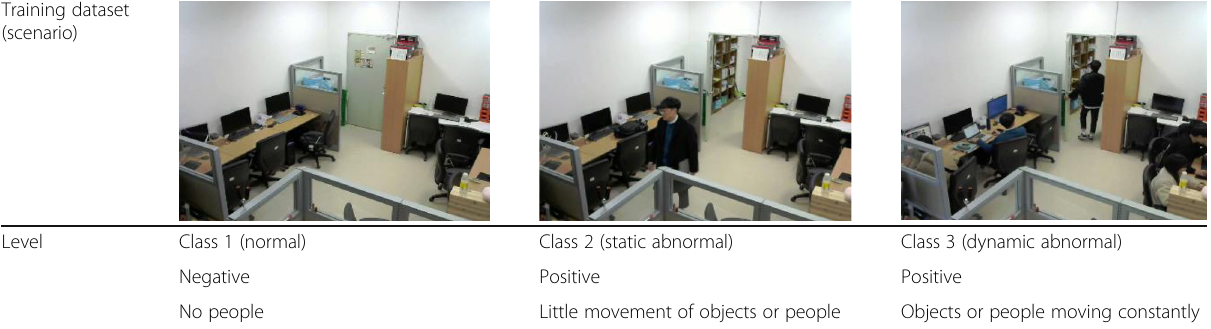
Table 1 Sample images classified into three levels Training dataset (scenario)